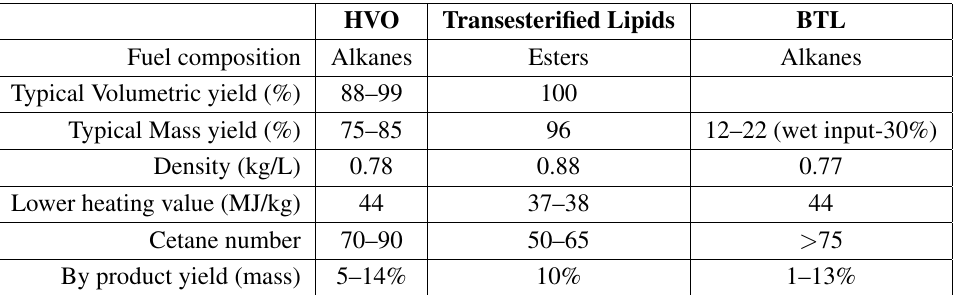
Table 1. Fuel properties